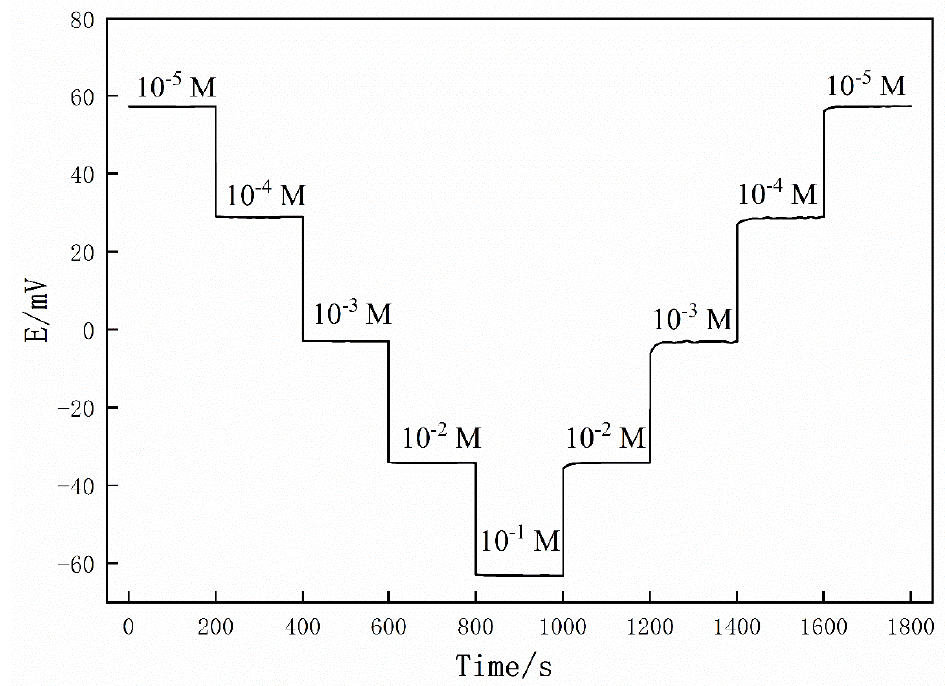
Figure 4. The calibration curve of the carbonate electrode for Na 2 CO 3 solutions with concentrations ranging from 10 − 5 M to 10 − 1 M.